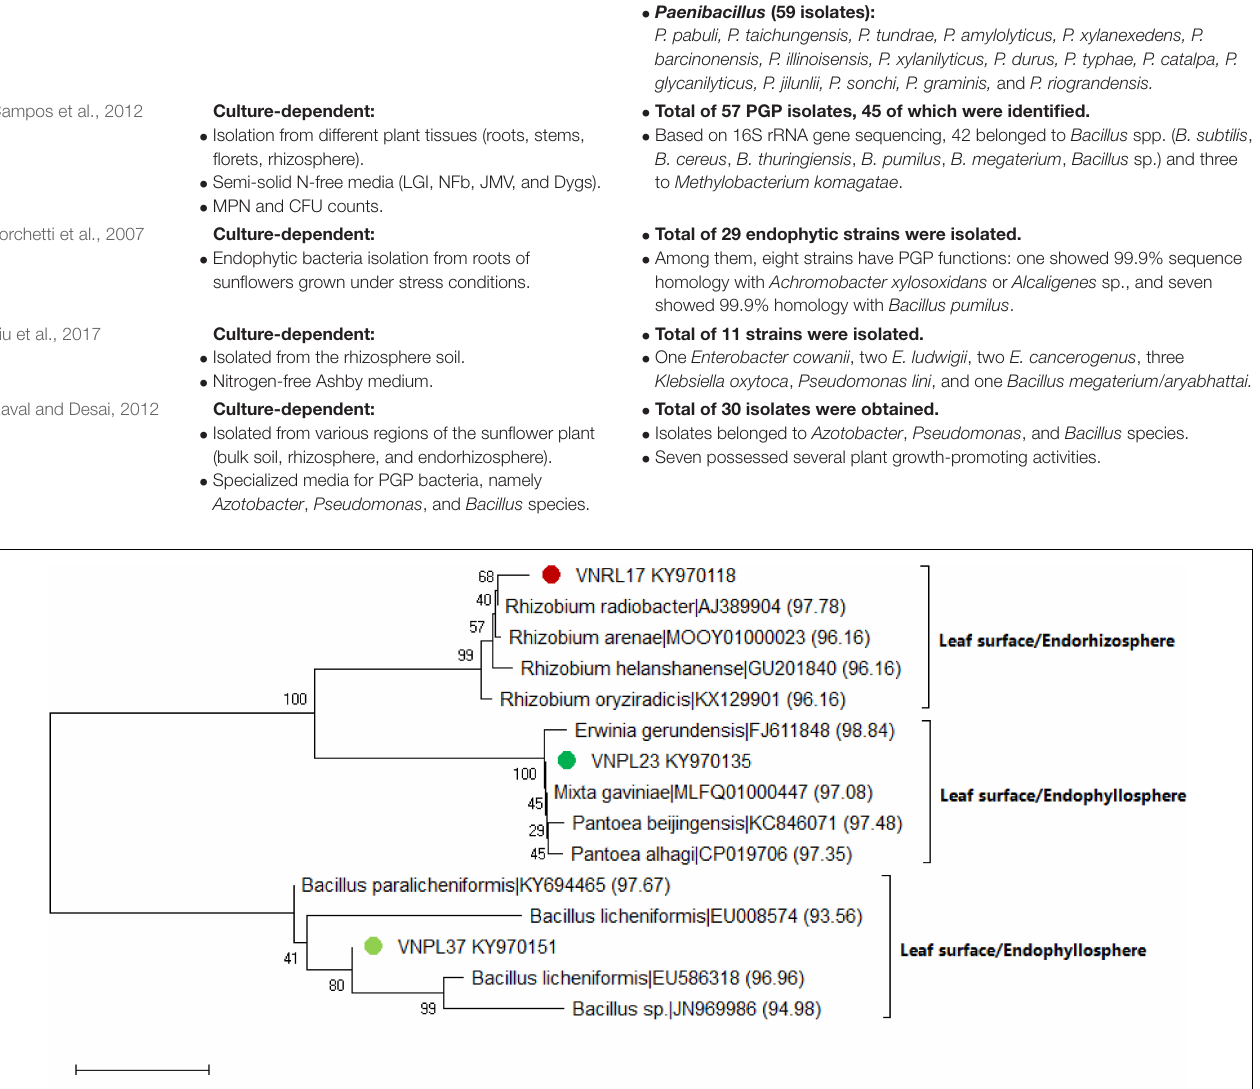
isolates of the endorhizosphere were clustered in one of the two main groups away from the second group containing the isolates of the endophyllosphere origin. The tanglegrams